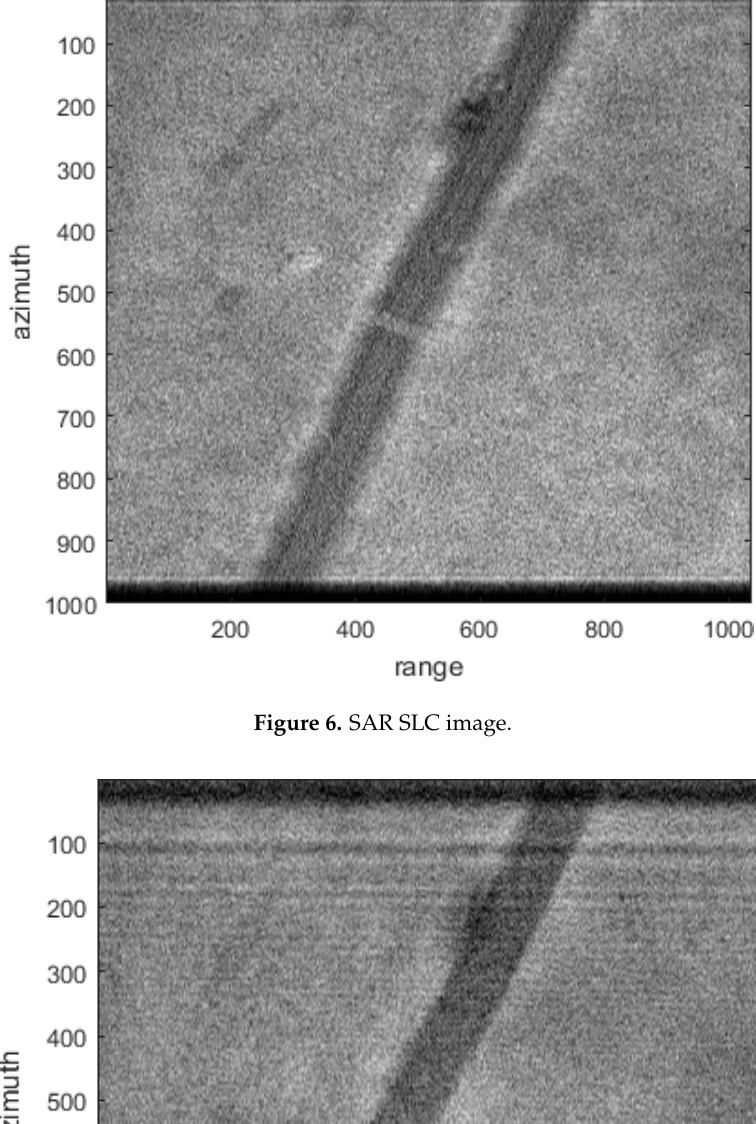
Figure 6. SAR SLC image.